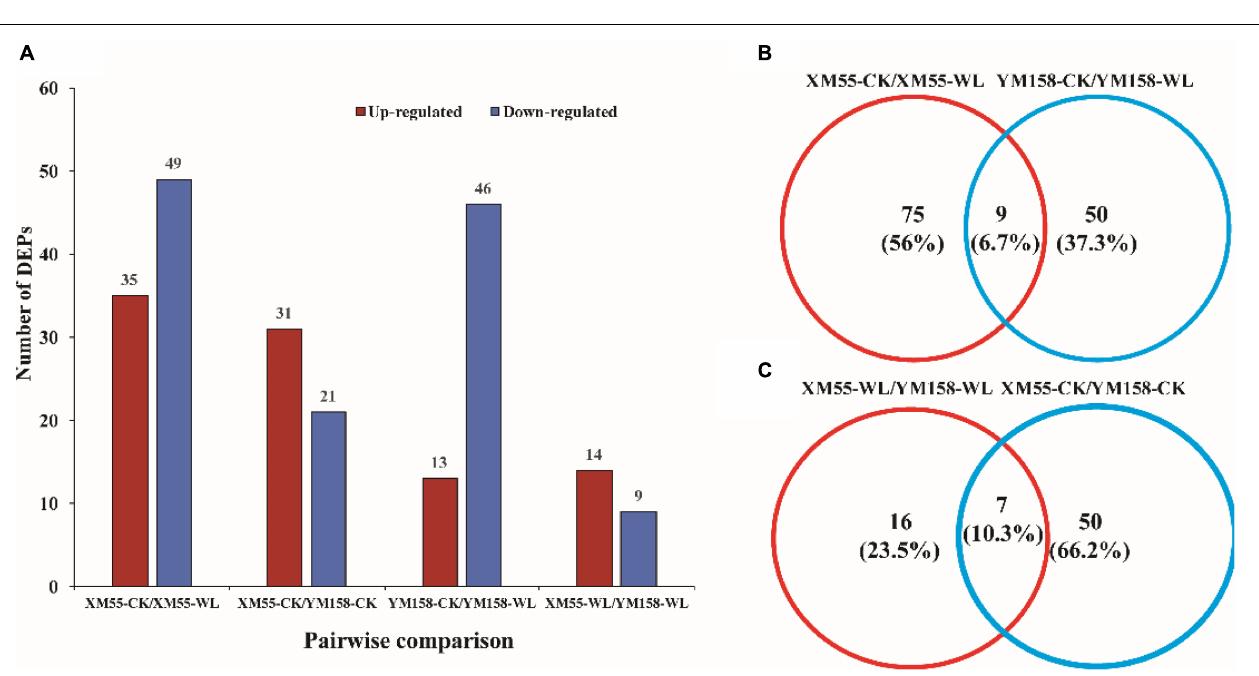
FIGURE 2 | Mass spectrometry analysis and protein identification. (A) The number of spectra and proteins. (B) The number of proteins with different unique peptides.